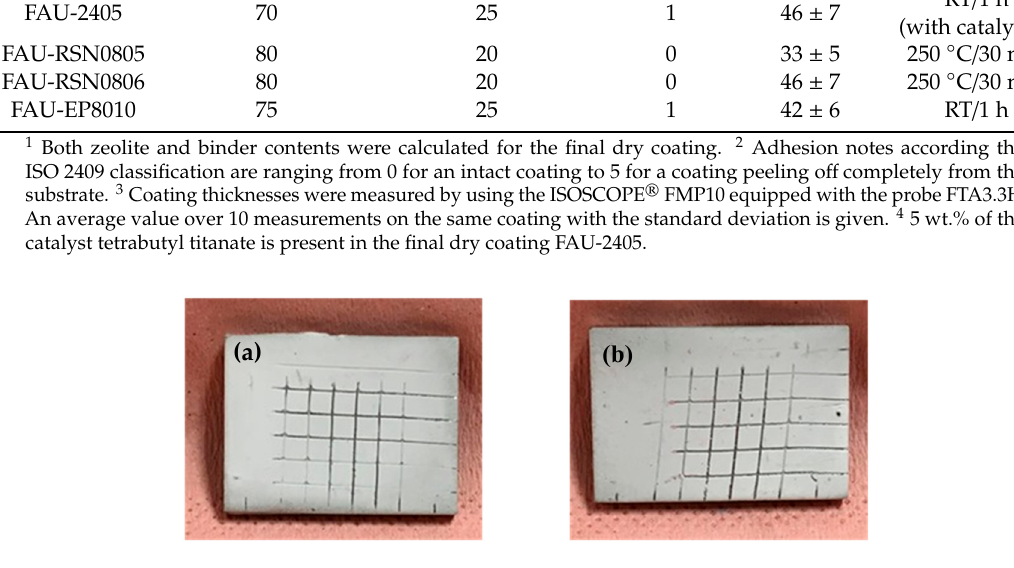
Figure 4. Adhesion test performed on zeolite coatings: ( a ) FAU-HK46; ( b ) FAU-RSN0805 .